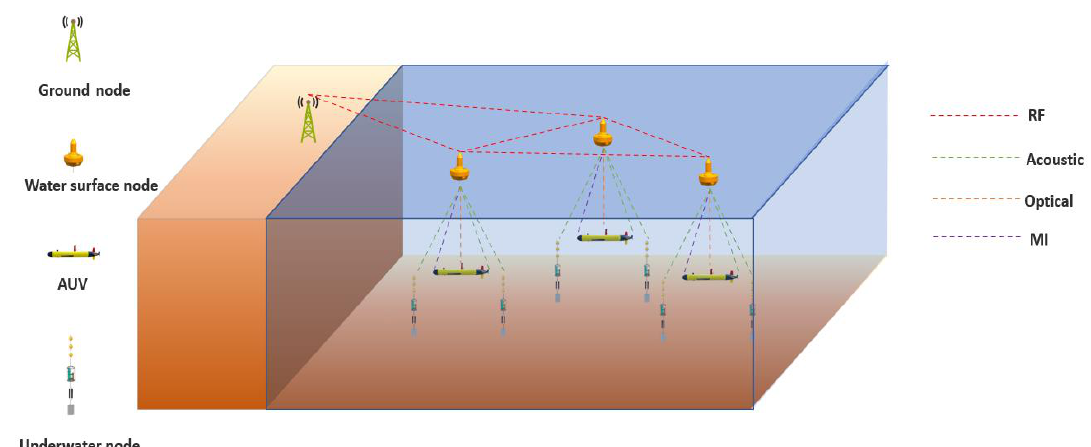
Figure 12. Case study for the MMNET. This study case includes four kinds of nodes: Ground node,